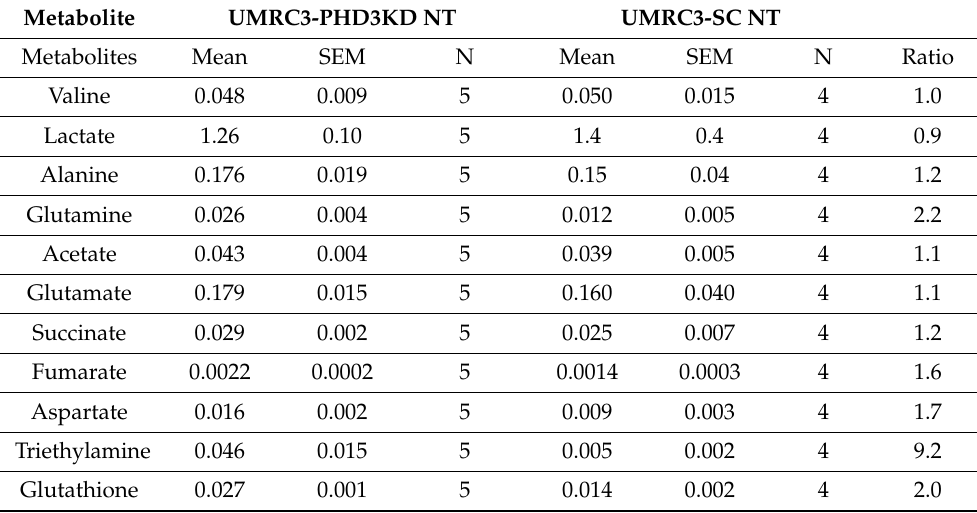
Note: The ratio is the UMRC3-PHD3KD mean value divided by the UMRC3-SC mean value. Abbreviations: SEM,